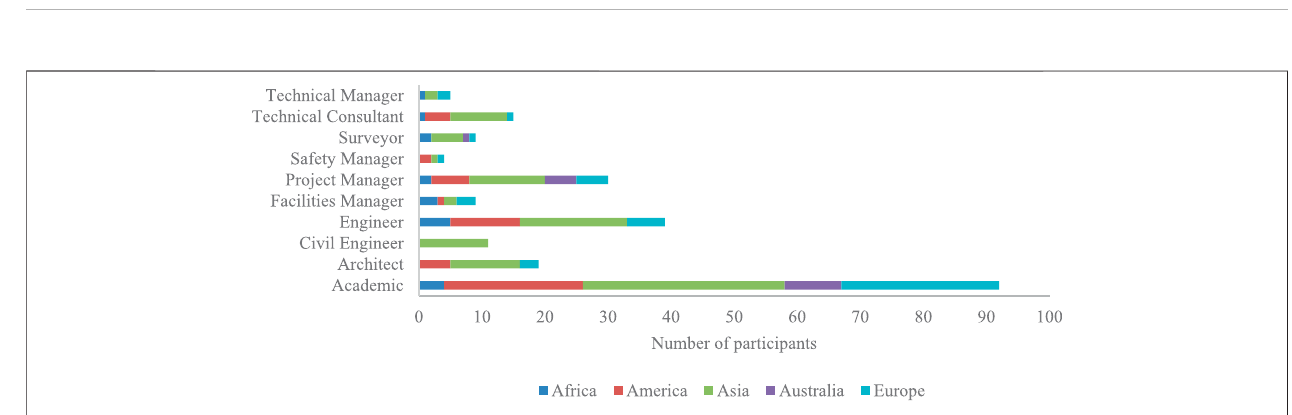
FIGURE 2 | The relationship between profession and the continent of residence.